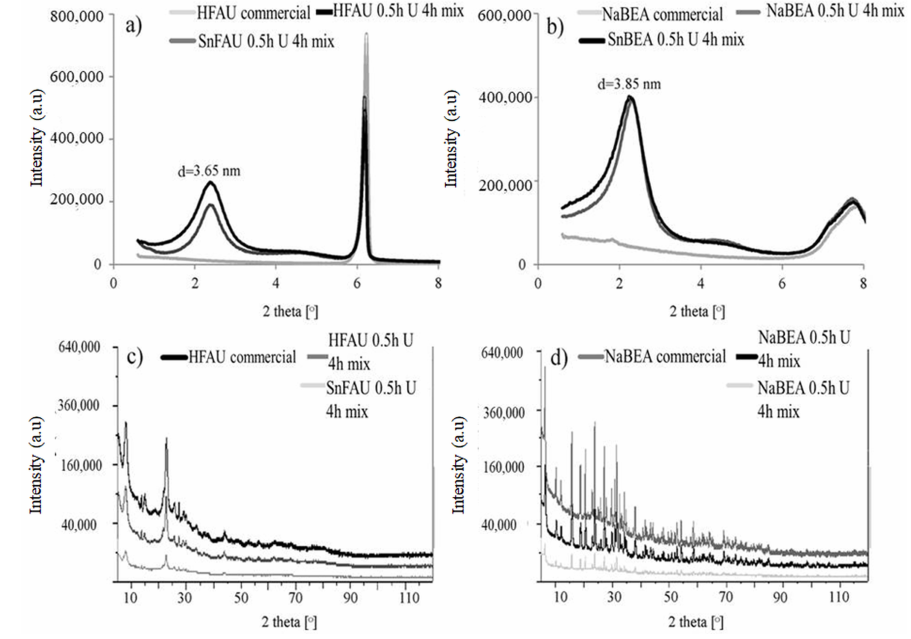
Figure 1. XRD (X-ray Diffraction) patterns of prepared hierarchical zeolites ( a – d